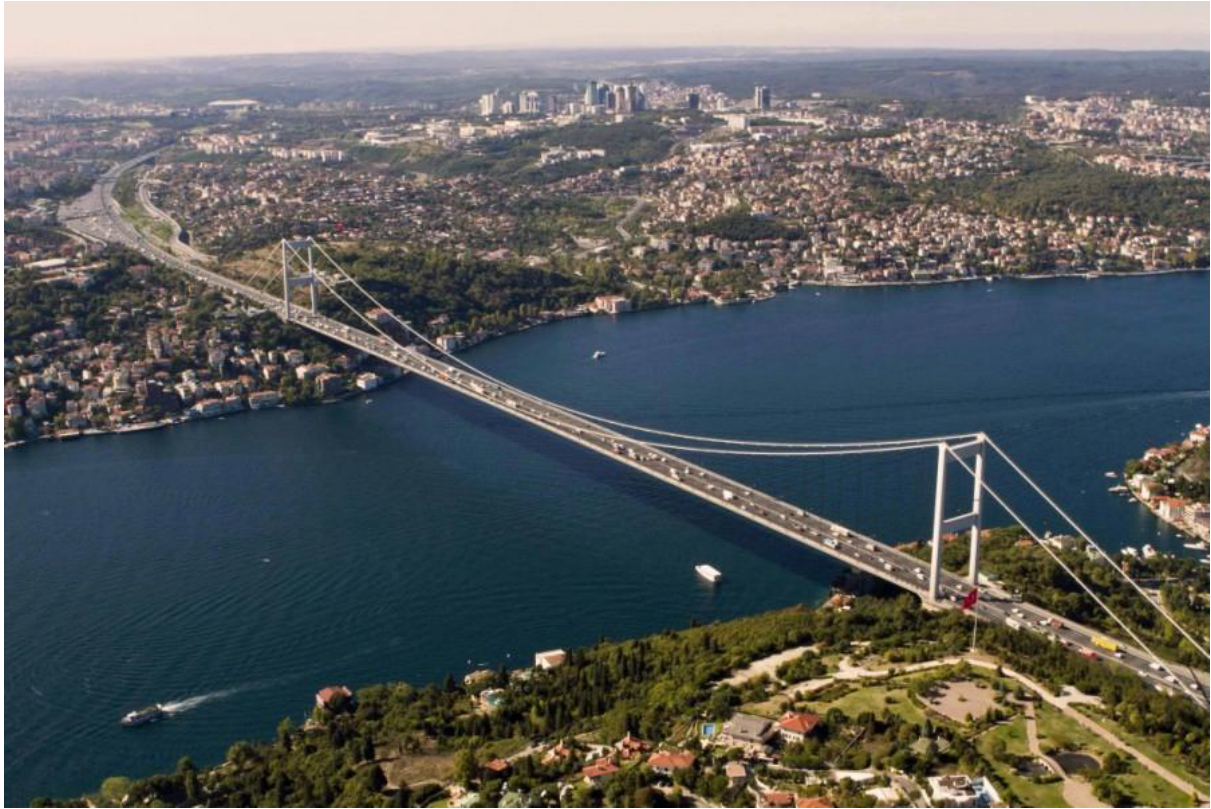
Figure 1. The second Bosphorus Bridge in